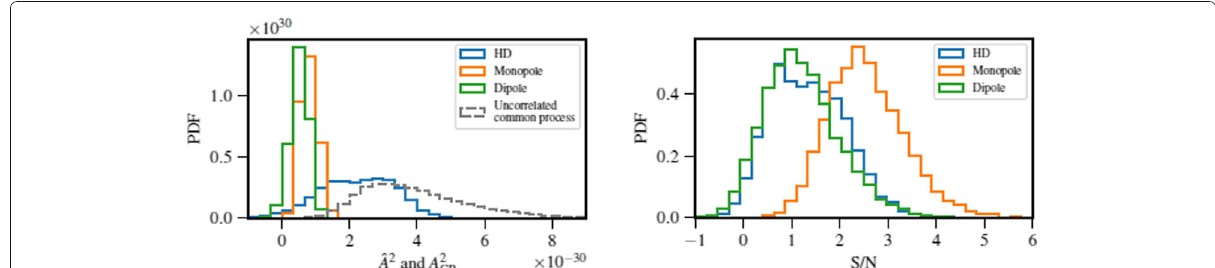
Fig. 5 Posterior distribution of the optimal statistic (upper panel) and S/N ratio (lower panel) for Hellings-Downs correlation (blue), monopolar (orange), and dipolar (green) angular correlations. Reproduced from [30] by permission of the